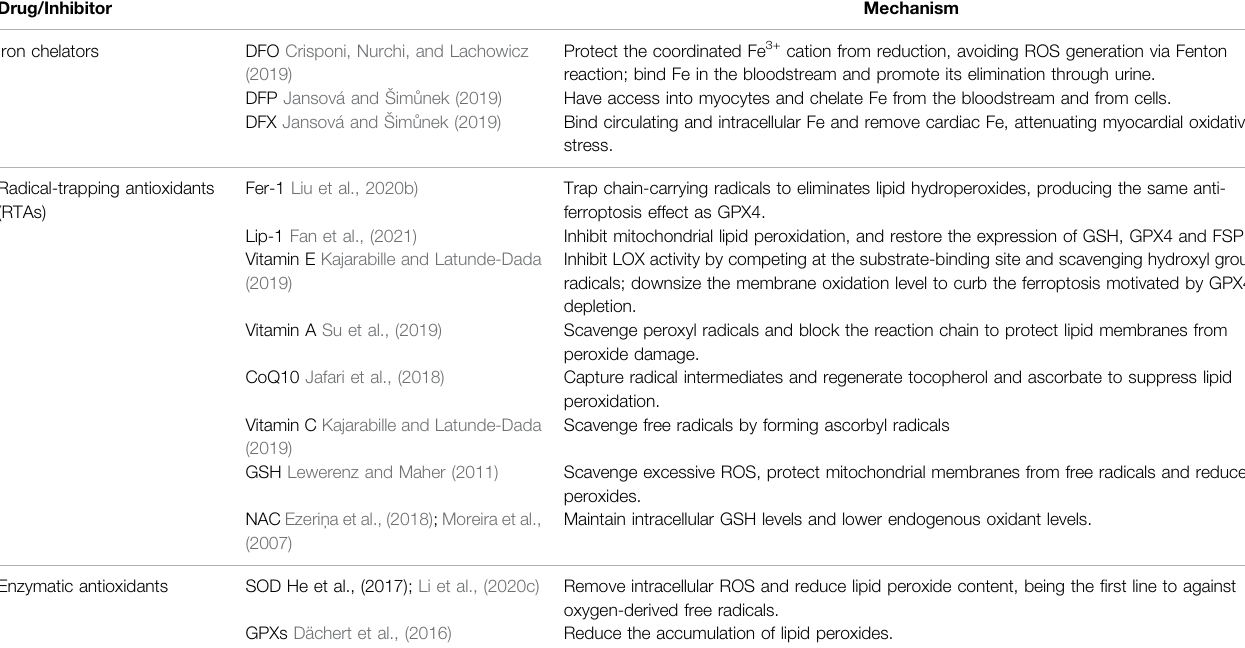
TABLE 2 | Treatment strategy of ferroptosis in cardio-cerebrovascular diseases.